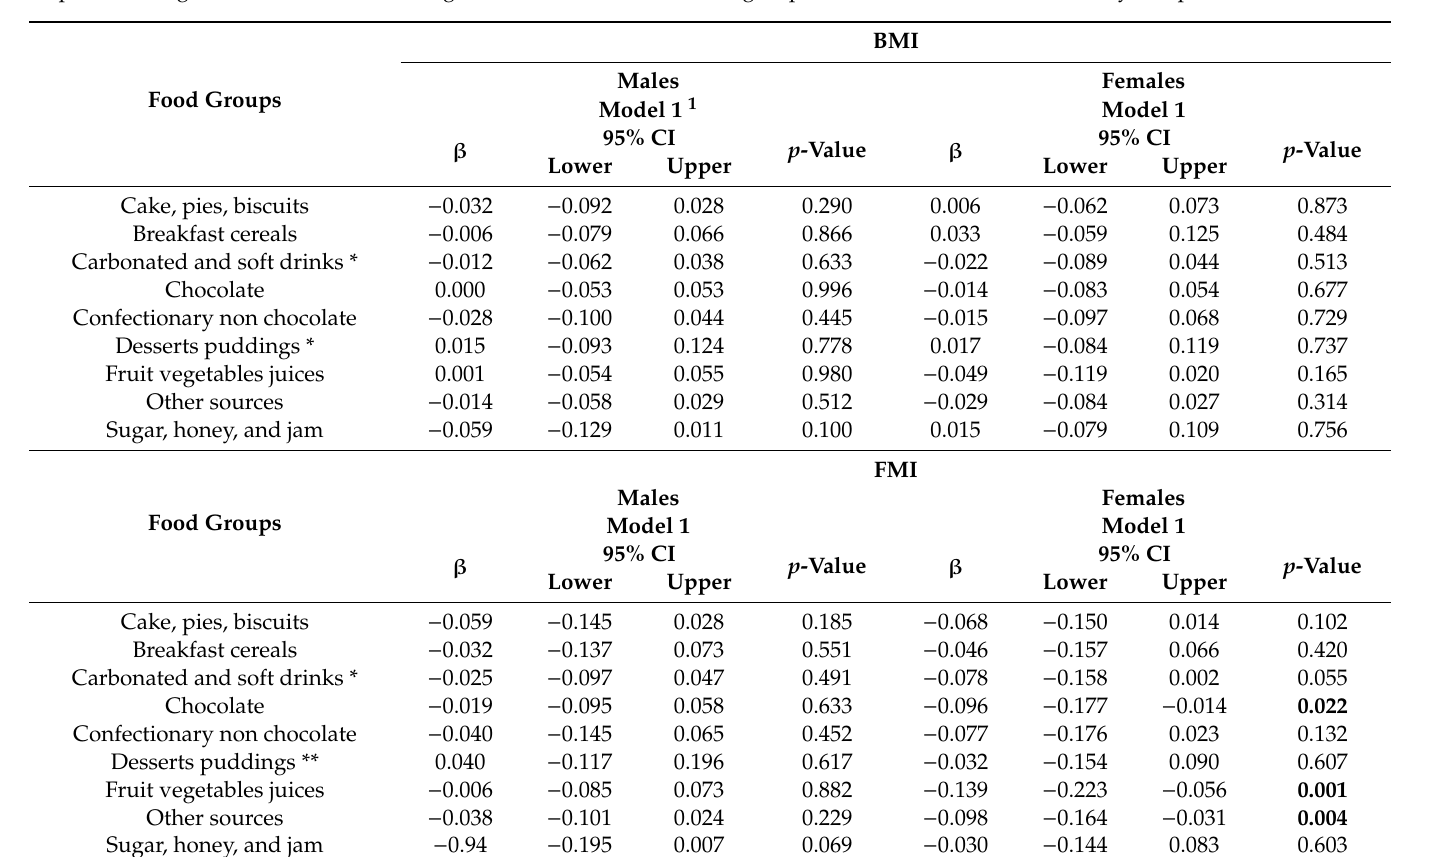
Table 4. Multiple linear regression models for free sugars intake from various food groups and their association with body composition indices between gender.